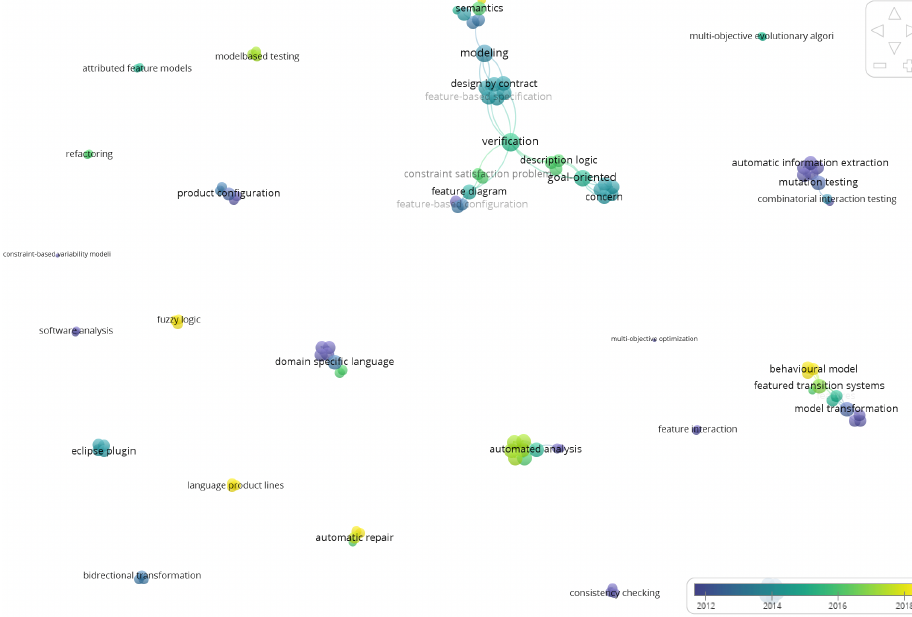
Figure 23. Relationship between most relevant